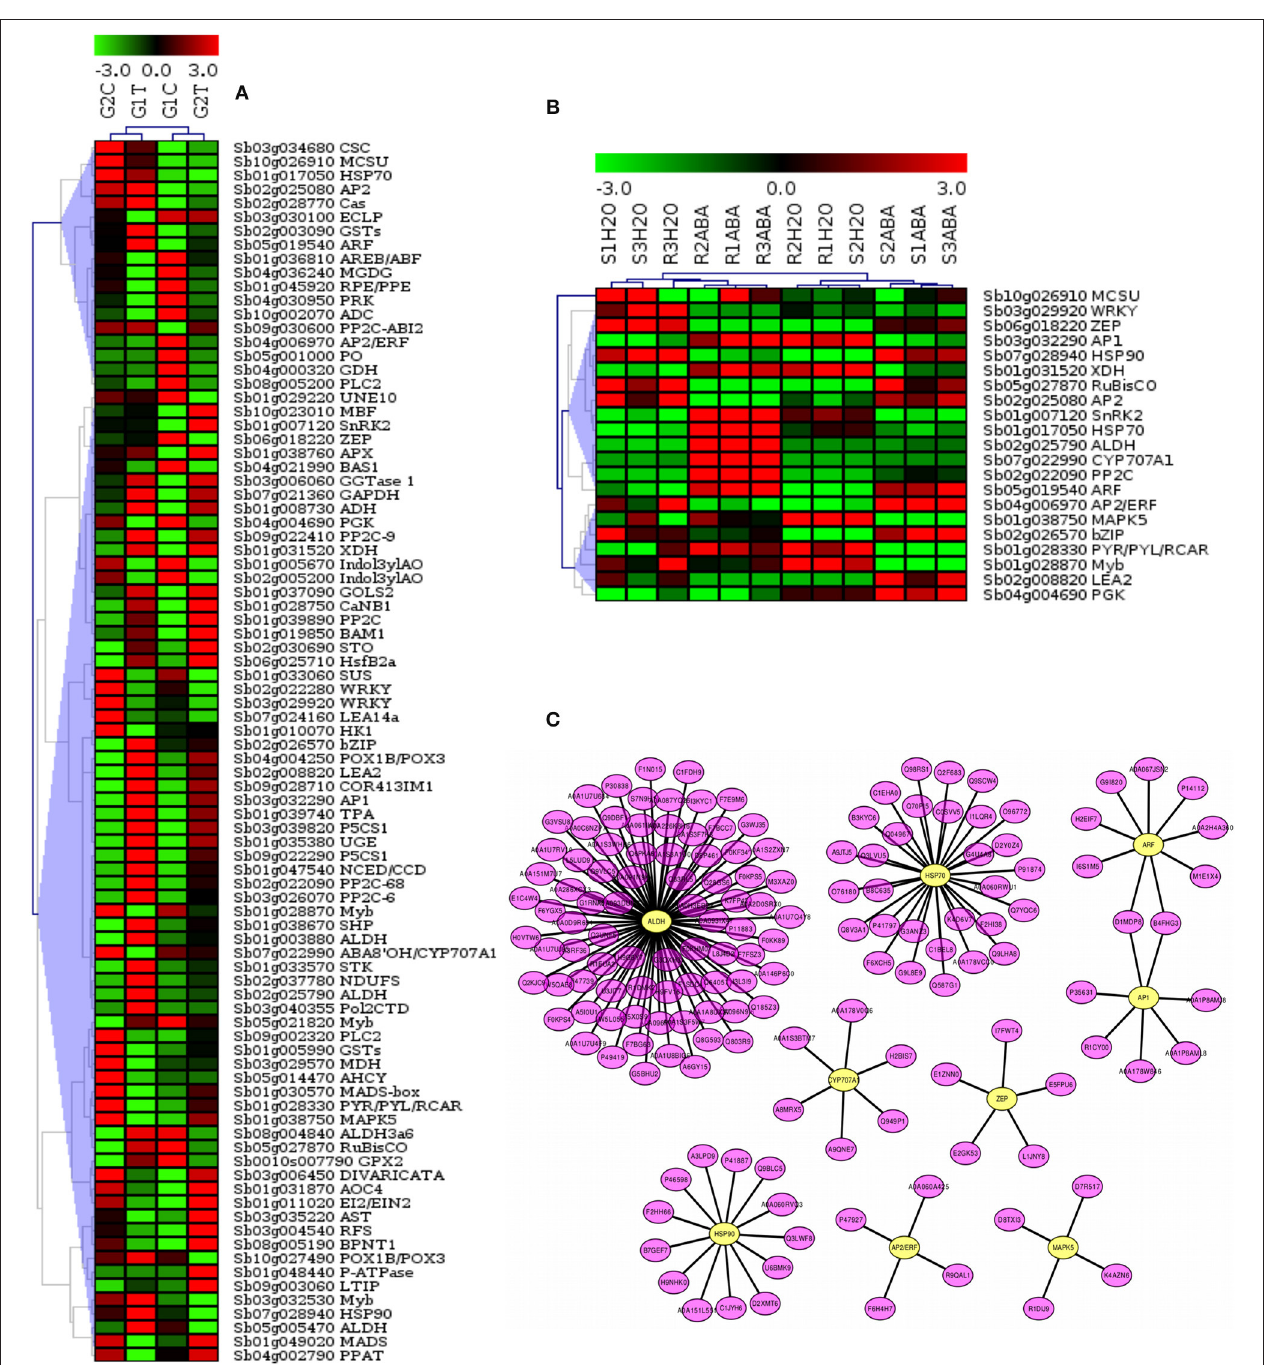
FIGURE 7 | Expression profiles of genes related to major plant stresses categories and the associated transcription factors (TFs) involved in the signaling pathways. The figure shows the hierarchical clustering of target drought expressed genes related to key pathways. Datasets from drought stressed leaf tissues of 2 sorghum varieties, GSE30249 (A) and sorghum root and shoot, GSE80699 (B) were used to show gene expression profiling. A sub-network of cross-talk based on expression profiles of target and associated regulatory genes related to ABA biosynthesis and other plant related signal transduction pathways is shown in (C) . The top regulatory genes involved in the drought-related pathways were indicated in the putative subnetwork for which expression profiles of the associate target genes were shown in (A) and (B) . Detailed description of the gene expression profiles and related TF genes are provided in Table S7 .